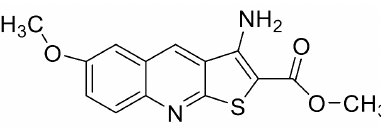
Figure 1. Chemical structure of methyl 3 ‐ amino ‐ 6 ‐ methoxythieno [2,3 ‐ b] quinoline ‐ 2 ‐ carboxylate (PU ‐ 48).